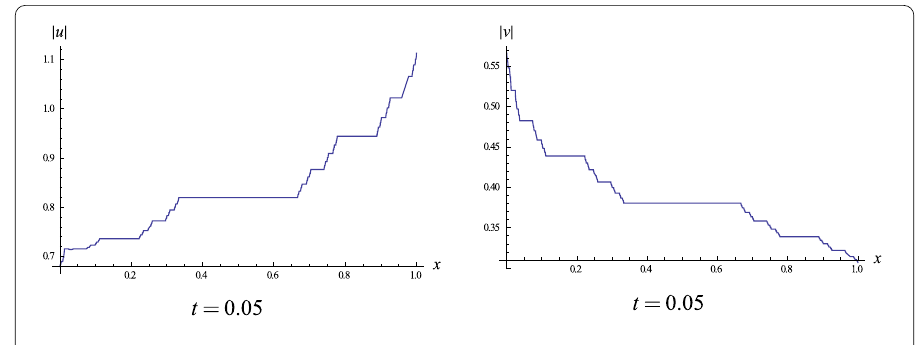
Figure 3 Profiles along the x axis of one-fractal solutions (78) with α = ln2/ln3.